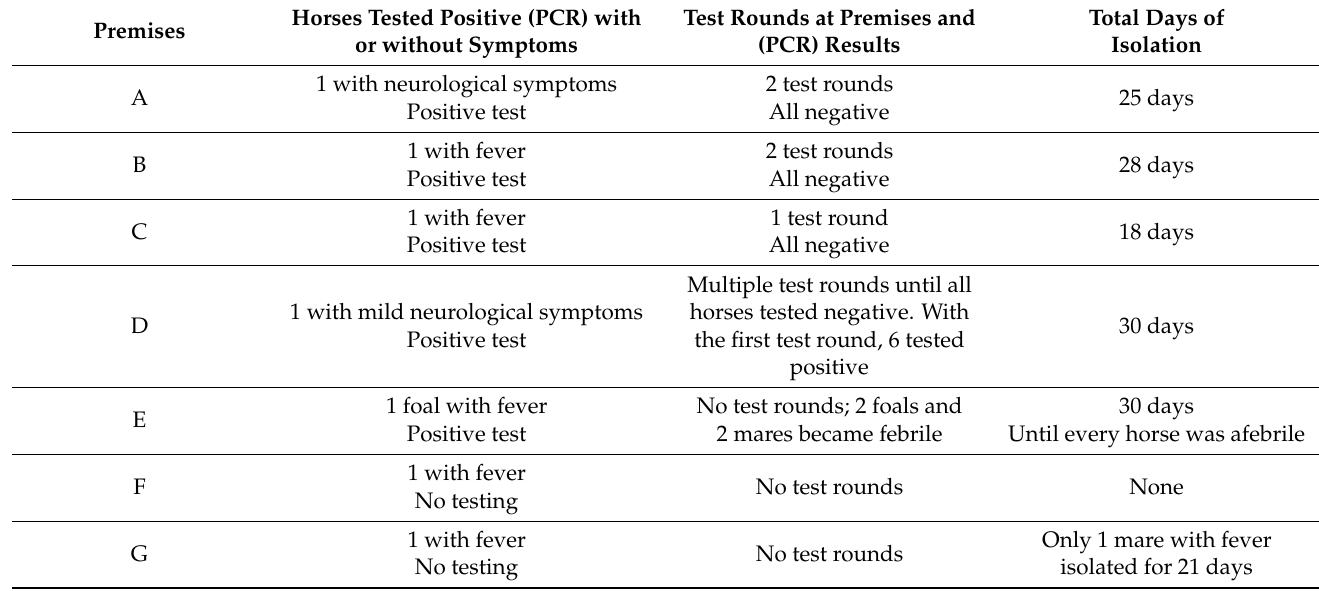
Table 2. Overview of the infected premises by the